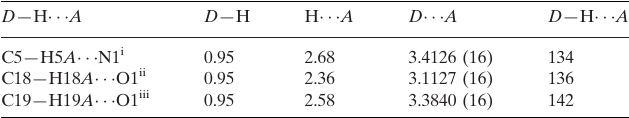
Hydrogen-bond geometry (A˚ , (cid:2)